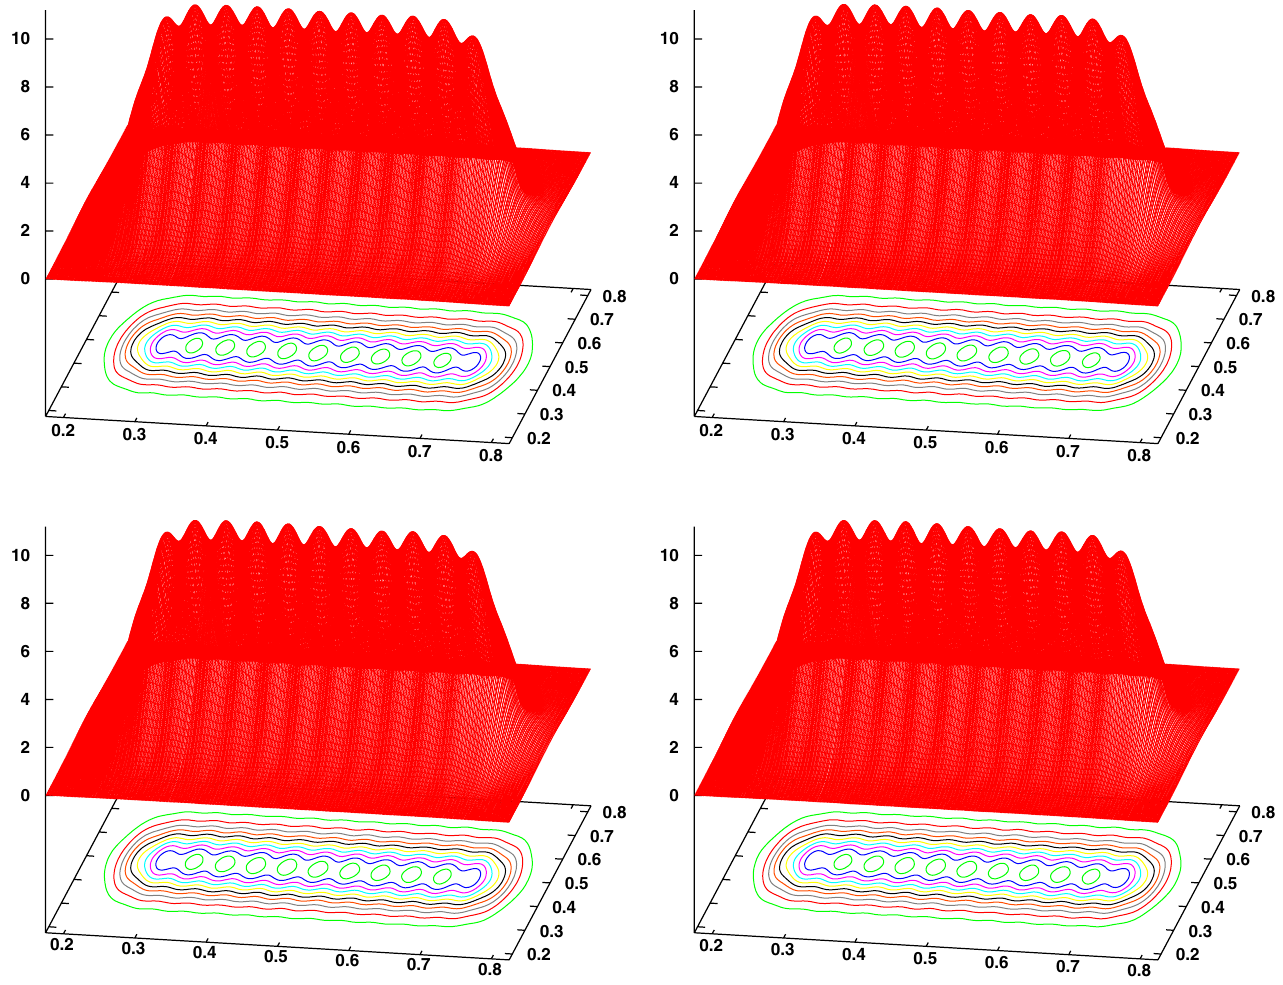
Þ with no self-fields for (cid:2) ; x 1 2 (bottom f